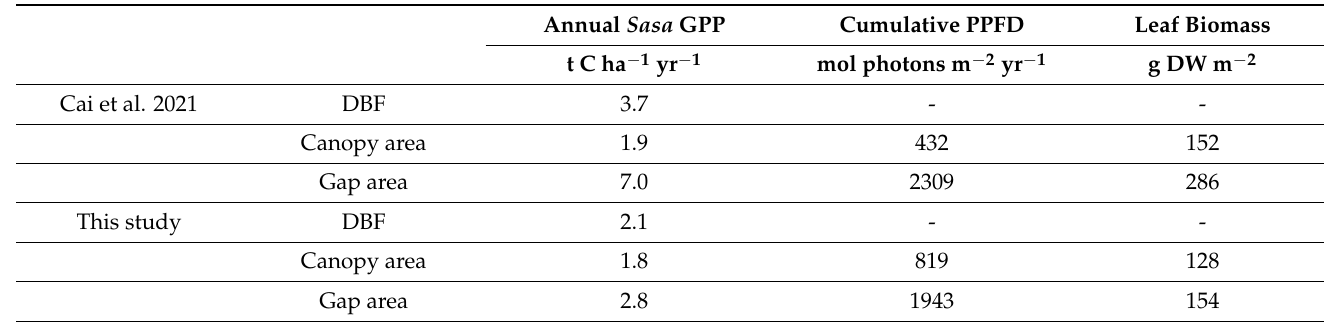
Table 6. Annual change of the annual Sasa GPP in the deciduous broadleaved forest and in the canopy and gap areas in that